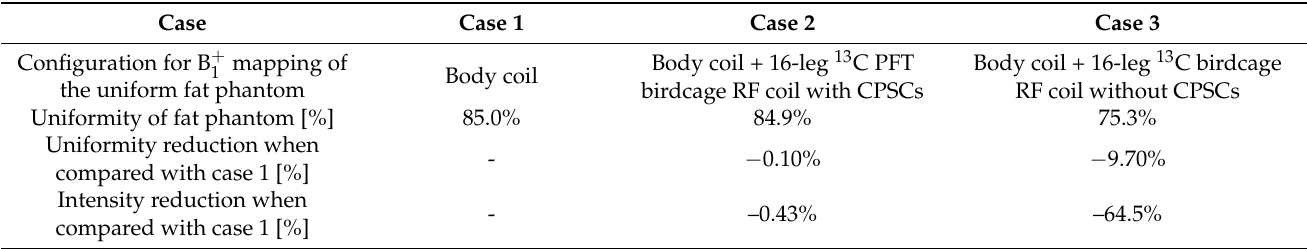
Table 2. Results of the uniformity of B + proposed CPSCs.